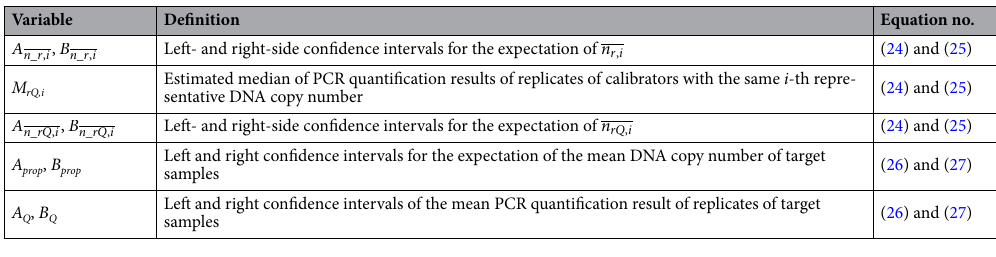
Table 1. List of variables and